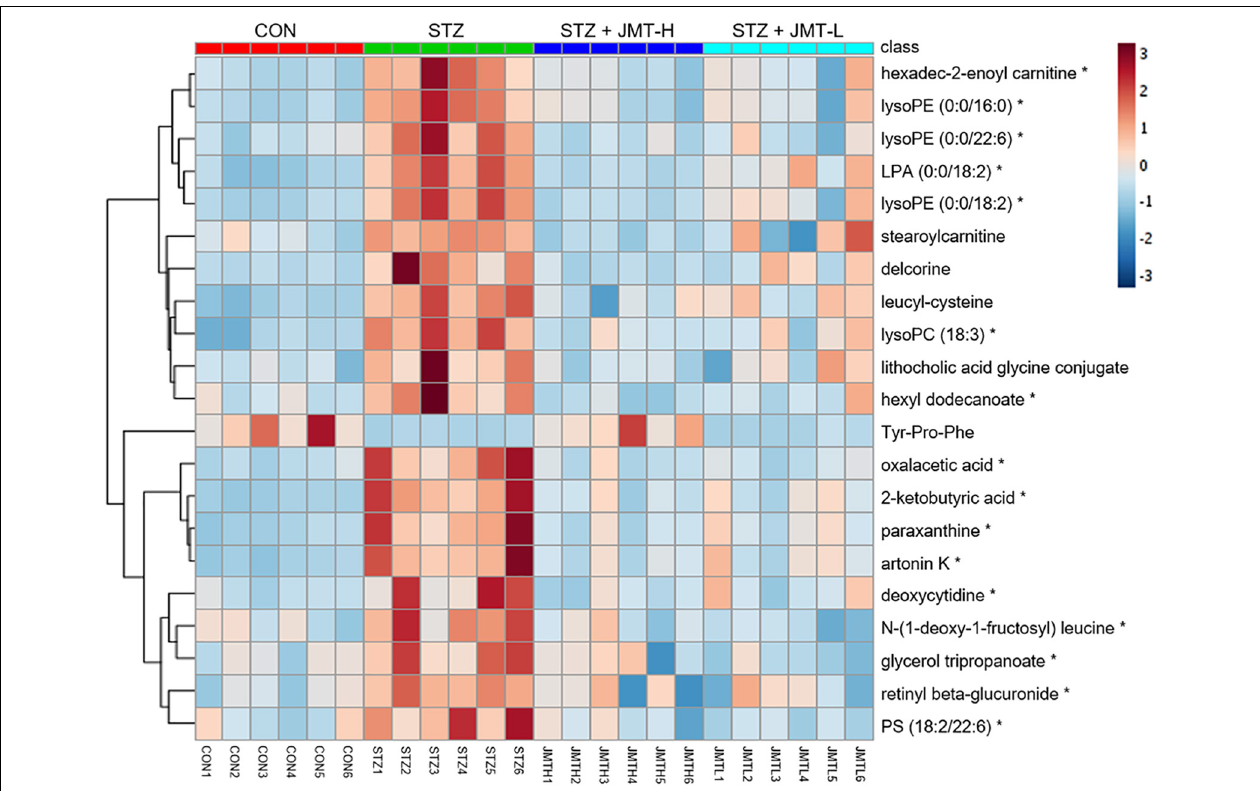
FIGURE 6 | Heat map of 21 metabolic biomarkers in each sample. The serum levels of the 21 metabolites significantly renovated by administration of JMT decoction at high dosage (JMT-H) in control (CON), STZ, STZ + JMT-H, and STZ + JMT-L groups ( n = 6 per group). *Metabolites also significantly renovated by administration of JMT decoction at low dosage